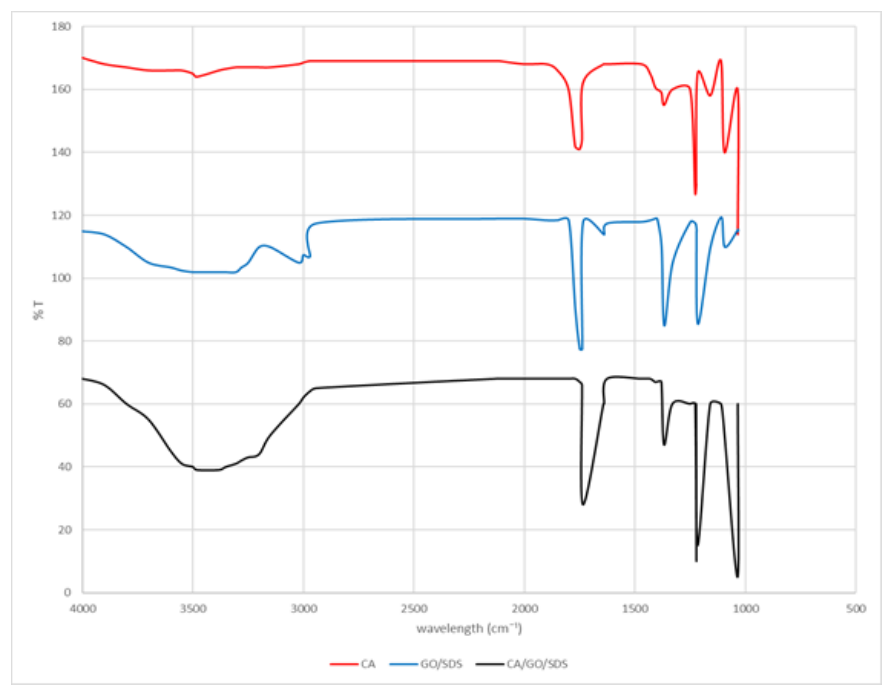
Figure 1. FTIR spectra for CA (red), GO/SDS (blue), and CA/GO/SDS (black) .